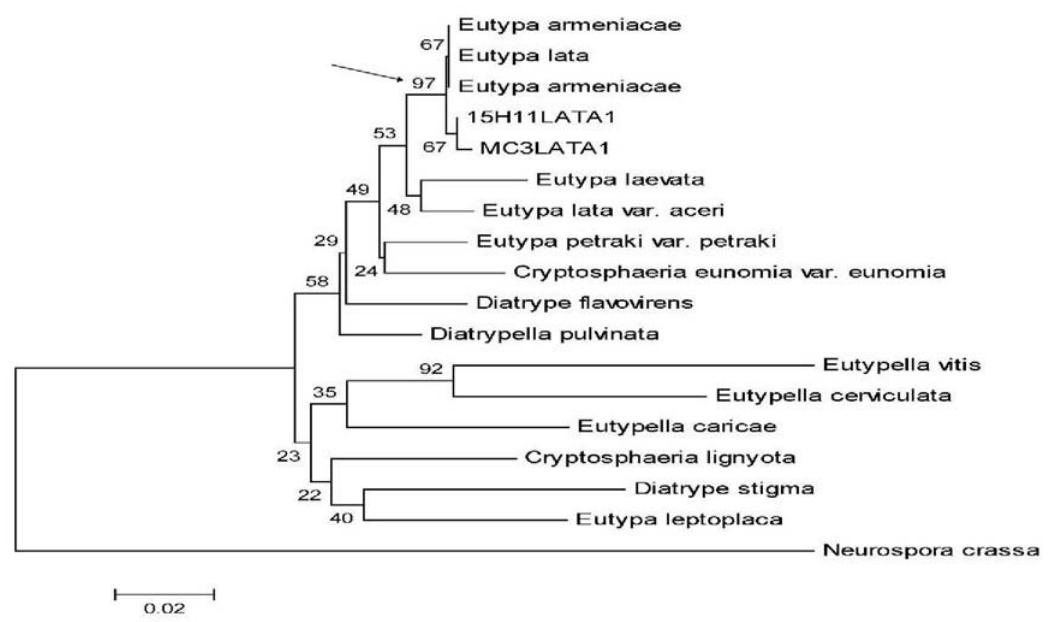
Fig. 3. Phylogenetic tree of the rDNA ITS1/ 5.8S/ITS2 region. Isolates 15H11 and MC3 were obtained from infected wood and ascospores respectively. GenBank accession numbers as in Acero et al. (2004) plus AY681193 for N. crassa